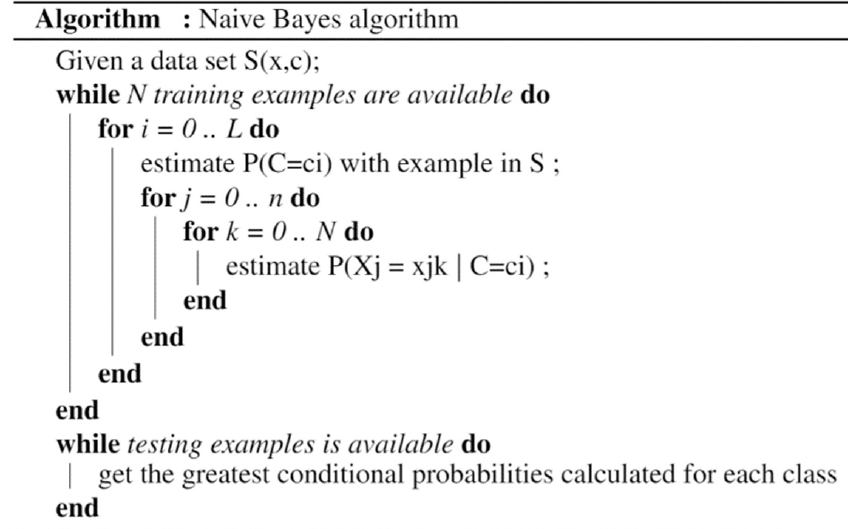
Figure 5. The pseudo code of the naïve Bayes algorithm [45] .